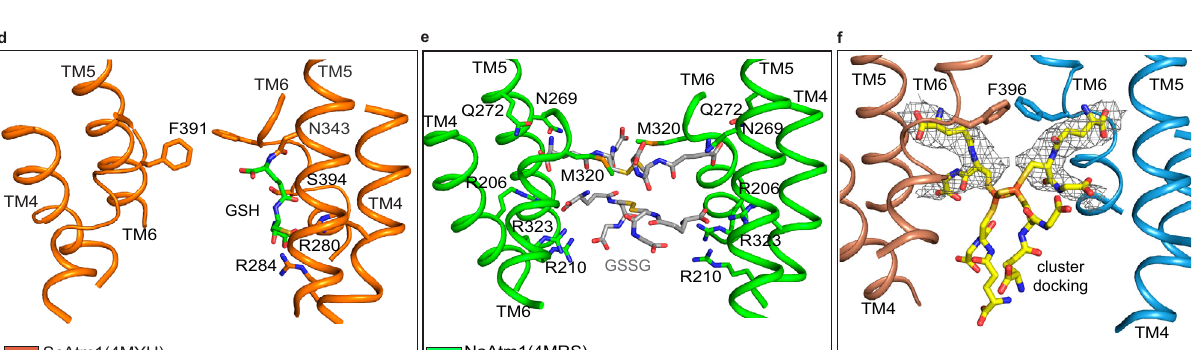
of the conformation of transmembrane helix TM6 between the inward-open (CtAtm1 inw-opn , gray) and the CtAtm1 inw-opn-occl (blue) states, demonstrating a con- siderablerearrangementofF396. d Identicalviewasinpanel b ofScAtm1withbound GSH (PDB-ID 4MYH). e Identical view as in panel b of NaAtm1 with bound oxidized GSH(GSSG)(PDB-ID4MRS). f Identicalviewasinpanel b withtheglutathione-bound [2Fe-2S] cluster, [2Fe-2S](GS4), partially fi tting in the cargo